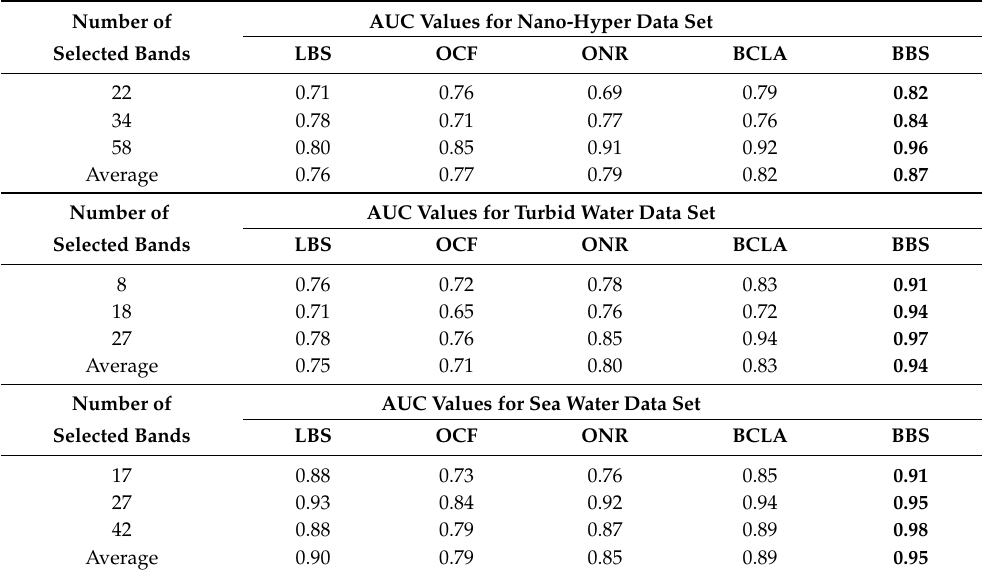
The bold entries represent the best performance in each row. Table 7. The AUC of ( P F , Threshold ) for the UTD results on all the data sets with different band selection methods.